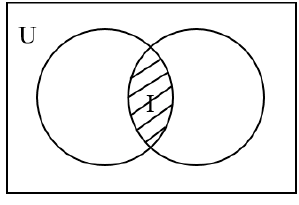
Figure 5. Intersection set I and universal set U .